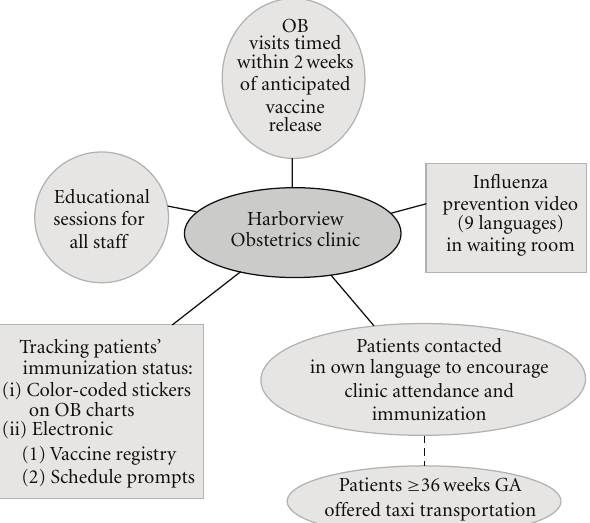
Figure 1: Clinic interventions used to increase H1N1 vaccine cov-